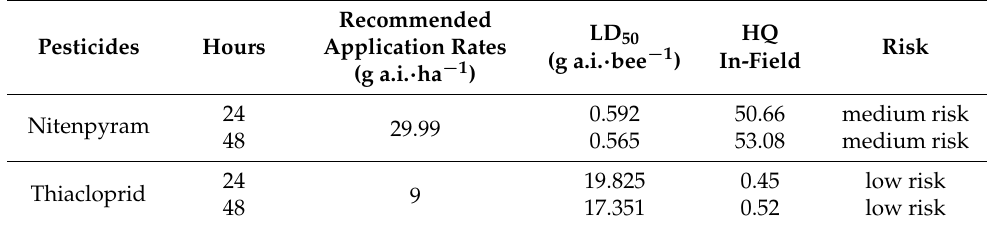
Table 4. Risk assessment of nitenpyram and thiacloprid to B. terrestris based on acute toxicity